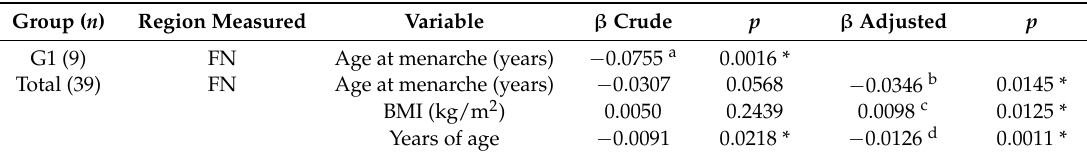
Table 4. Regression analyses of femoral neck BMD, age at menarche, BMI, and years of age in the total population and